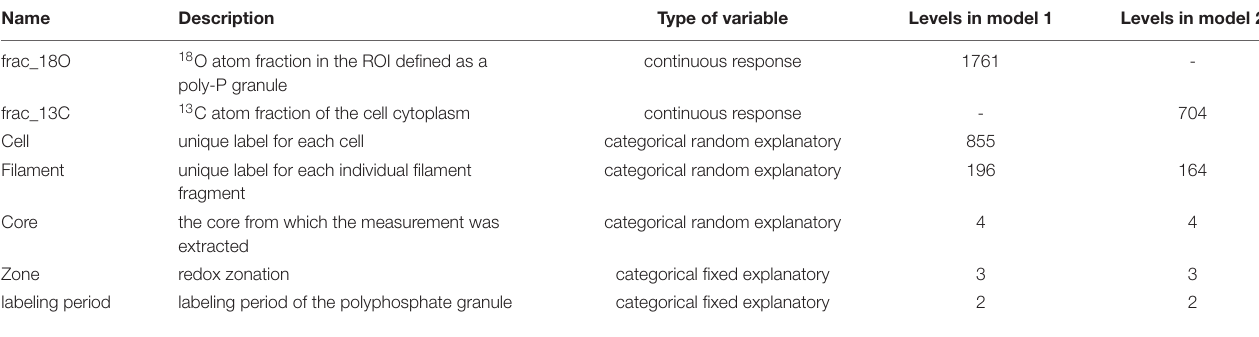
TABLE 2 | Description of the different variables used in the linear mixed